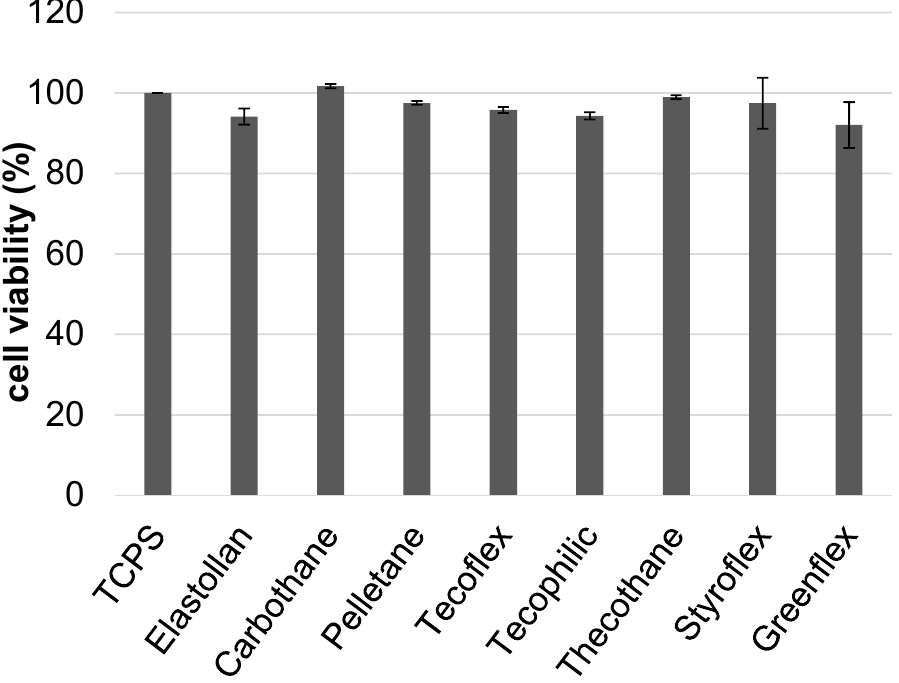
Figure 2. Biocompatibility of the tested polymer samples. Urothelial cells are not impaired by any of the polymers tested (100% reference = tissue culture polystyrene (TCPS), HUC-1 cells, mean ± SD, ANOVA post hoc Bonferroni n.s. at p < 0.05).